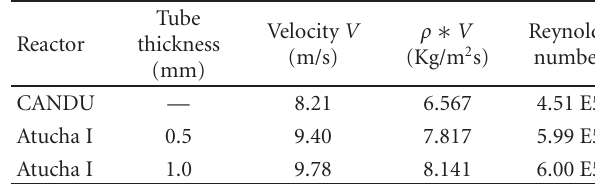
Table 10: Flow excitation parameters for CARA